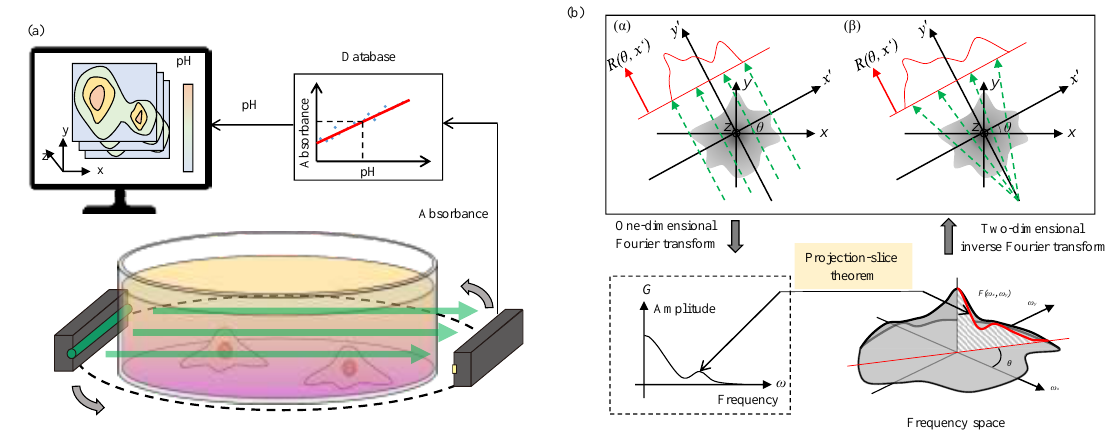
Figure 1. A method to measure pH distribution by computed tomography (CT) scan. ( a ) The concept of the system and ( b ) the algorithm of CT scan using the projection-slice theorem by (α) parallel beam or (β) fan beam.